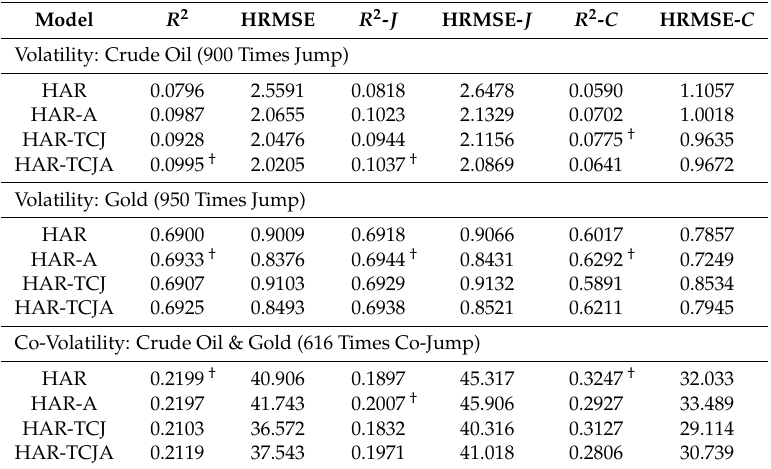
Table 4. Out-of-sample forecast evaluation for daily regressions.